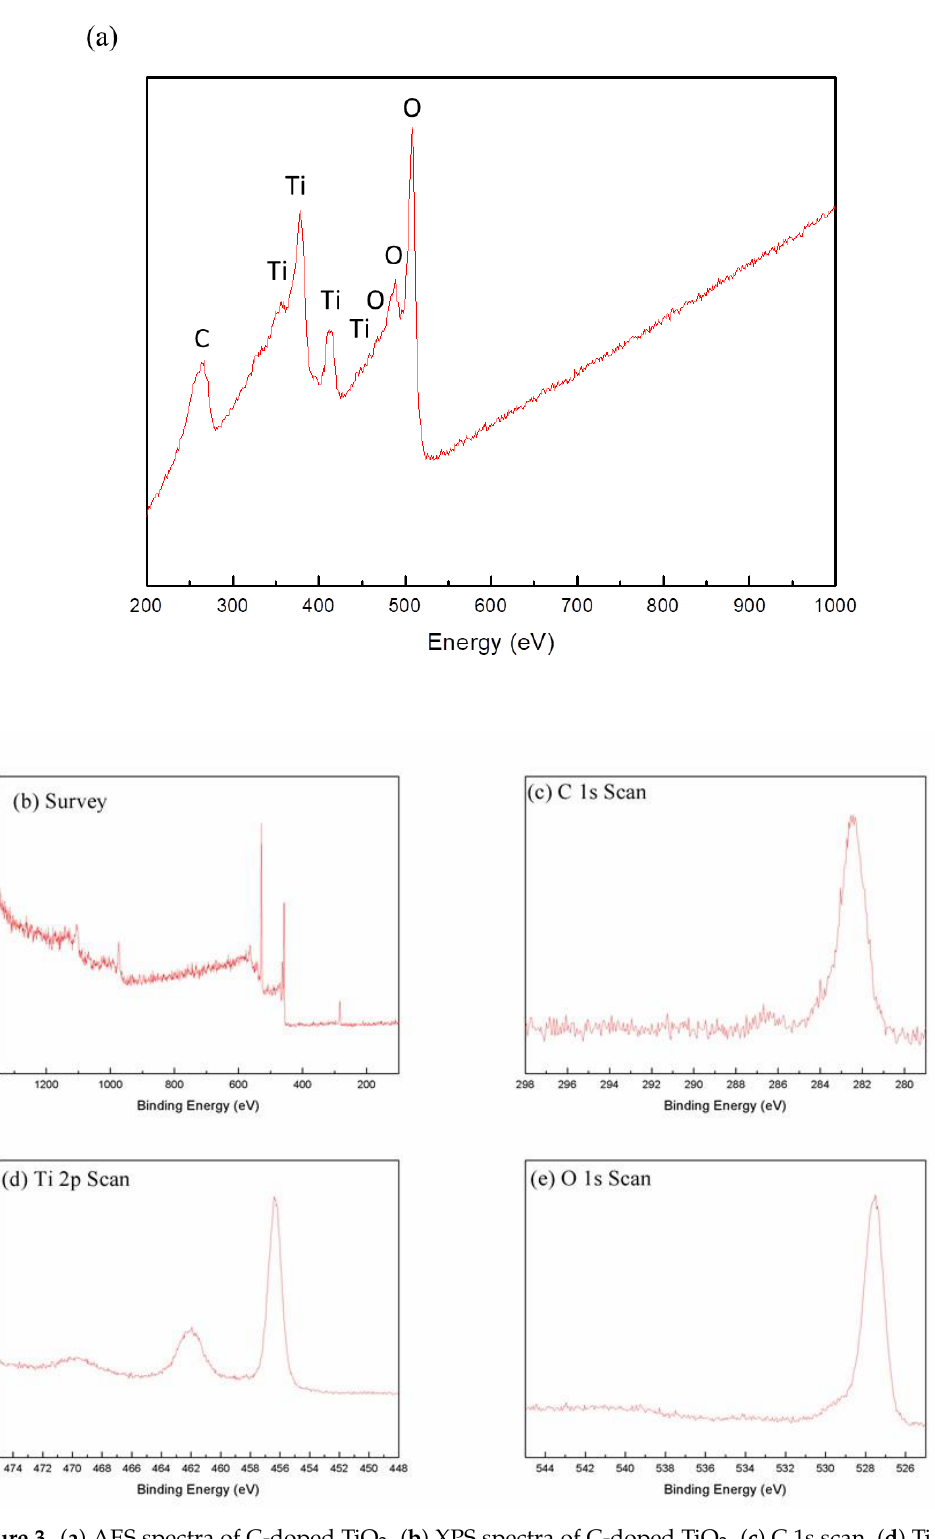
Figure 3. ( a ) AES spectra of C-doped TiO 2 , ( b ) XPS spectra of C-doped TiO 2 , ( c ) C 1s scan, ( d ) Ti 2p scan and ( e ) O 1s scan and ( e ) O 1s scan.